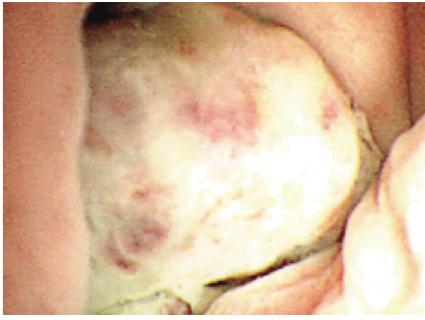
Figure 1: Appearance of the nodule during flexible cystoscopy.